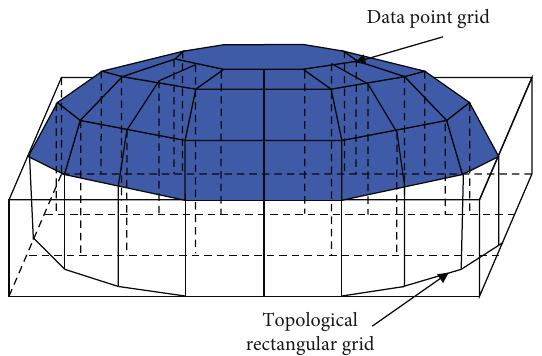
Figure 1: 7 × 7 data point grid and corresponding topological rectangular